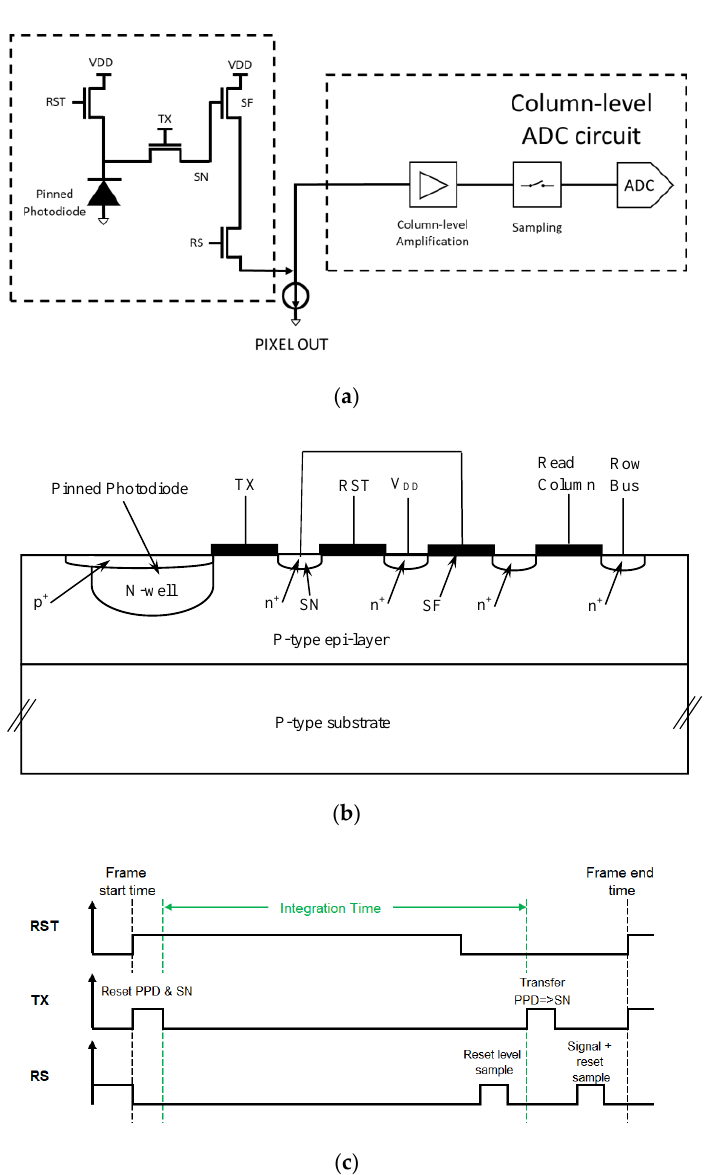
Figure 1. ( a ) A schematic overview of the pixel, marked by the dashed line, with its readout chain, marked by a separate dashed line. The column-level ADC circuit is presented schematically. ( b ) Schematic cross-section of the pixel. The Floating Diffusion (FD) of the Transfer Gate is the Sensing Node (SN), which is connected to the gate of the Source Follower. ( c ) The timing diagram showing how the thermal noise of the reset operation is reduced. The first sample measures the noise, while the second sample measures the same noise and the signal. By subtracting the two readings, this noise is canceled.